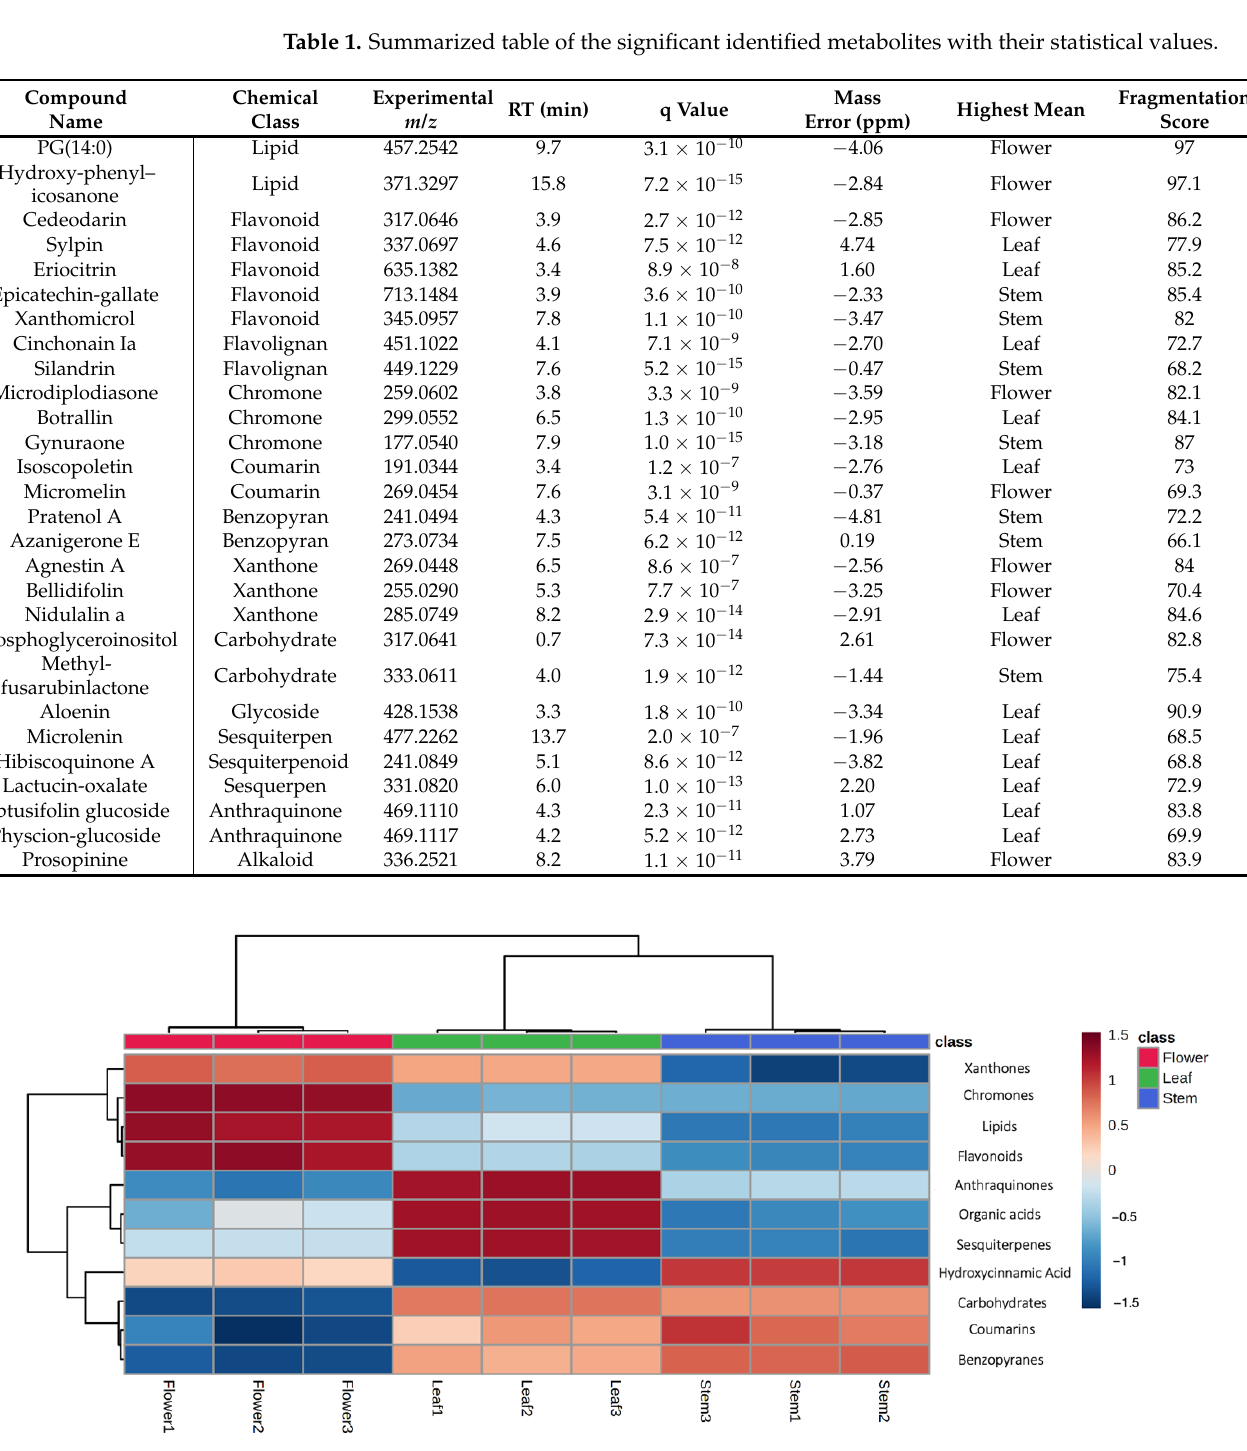
Figure 4. Variable trend plots of the most discriminant metabolite classes: phenolics ( A ) and chro- mones ( B ) are overexpressed in the flowers, while sesquiterpenes ( C ) and benzopyrans ( D ) markers had the highest influence to discriminate leaves and stems. Flower was the organ richest in flavonoids, including seven quercetin-glycosides de- rivatives in negative ionization mode, as reported in a previous phytochemical profiling